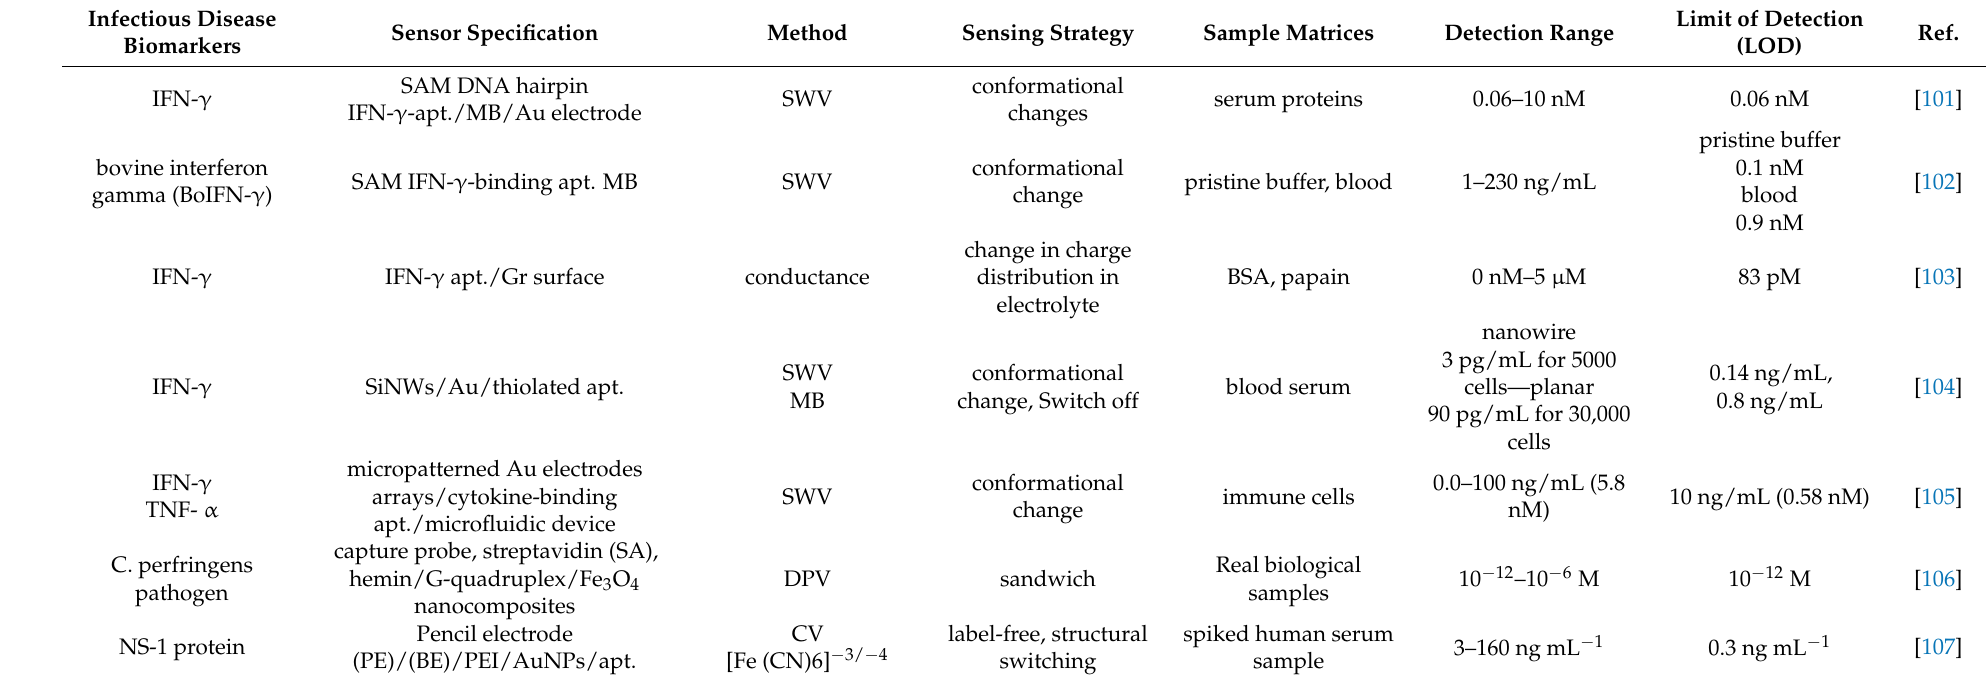
Table 3. Specifications of electrochemical aptasensors for infectious disease